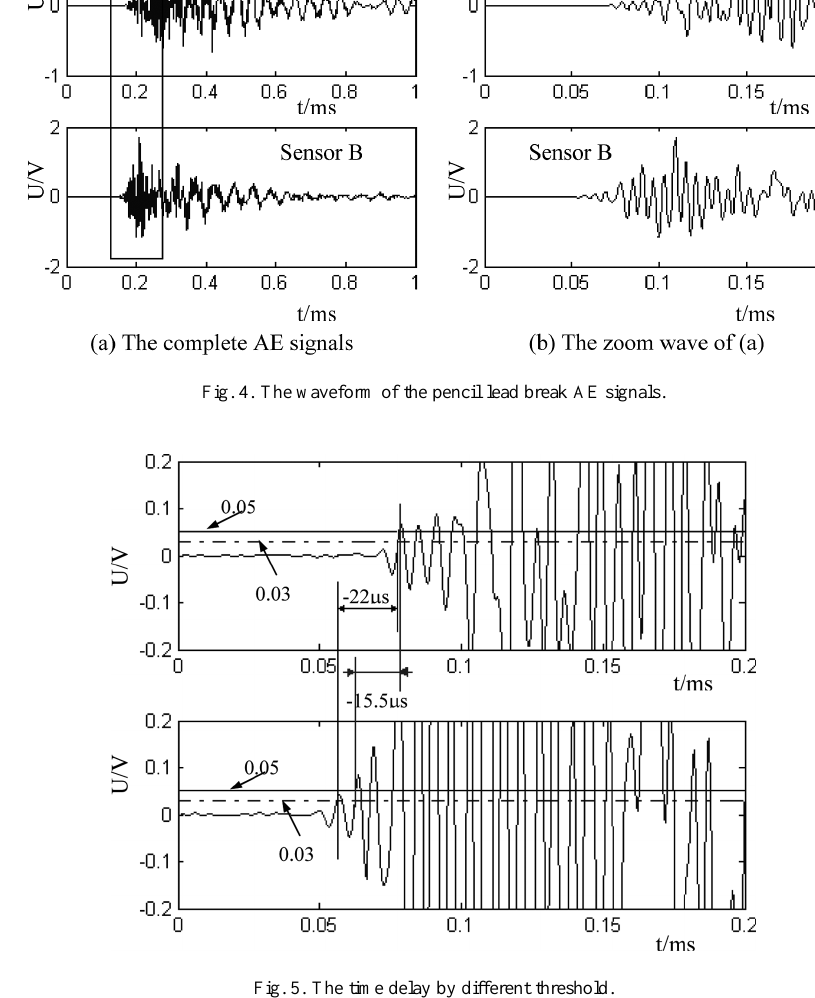
Fig. 5. The time delay by different